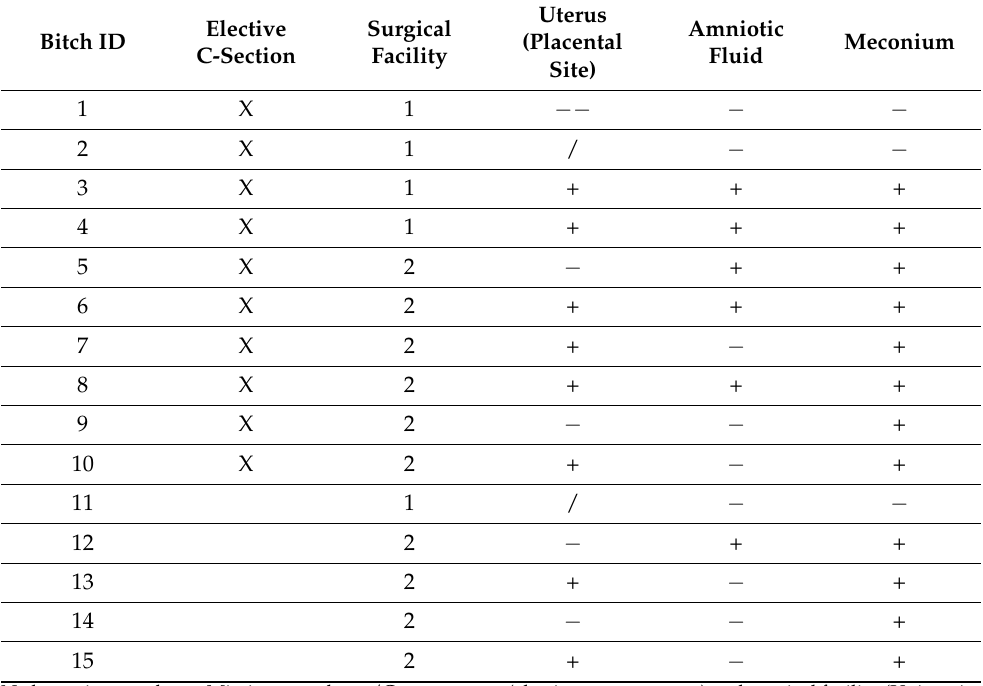
Table 2. Positive cultures in the three locations (uterus, amniotic fluid, meconium), sampled when extracting the first